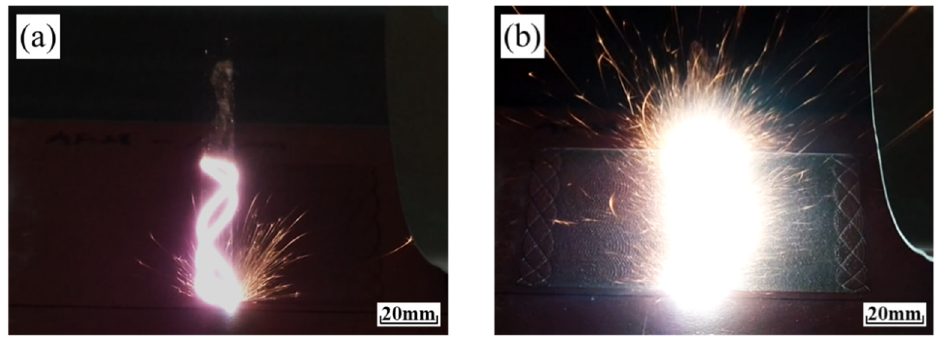
Figure 12. Laser-induced plume/plasma images under the ( a ) paint residual and ( b ) removal conditions during laser cleaning with wave clean beam pattern.